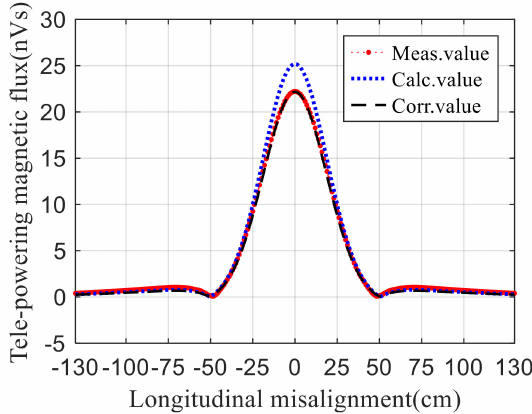
Figure 13. Validation results of the tele-powering field conformity